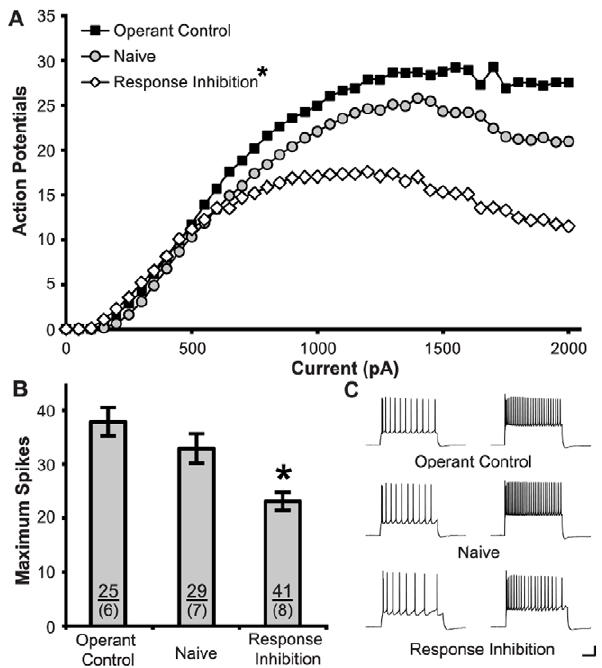
Figure 2. Training on the RI task reduced the intrinsic excitability of prelimbic neurons. A. Action potentials were produced by increasing current steps (800 ms, 50 pA steps). Learning the RI task produced less spiking than Operant Control and Naı¨ve conditions. B. Learning the RI task decreased the maximum number of action potentials evoked. Sample sizes for subjects (above) and cells (below) are indicated within the bars. C. Representative traces show action potentials generated by 500 pA (left) and 1500 pA (right) current steps for RI, Operant Control, and Naı¨ve subjects. (Calibration Bars: 20 mV/0.1 s; * : p , 0.05 vs. all groups).